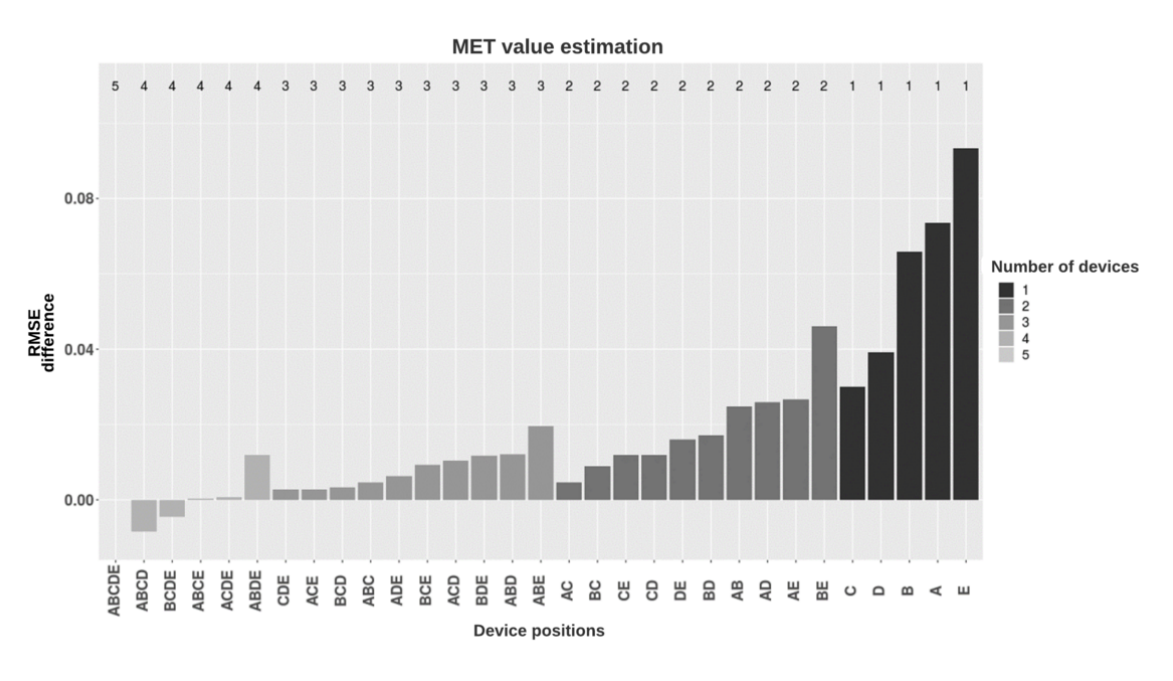
Table 3. Guideline table to determine the needed number and placement of the wearable accelerometer for each task.